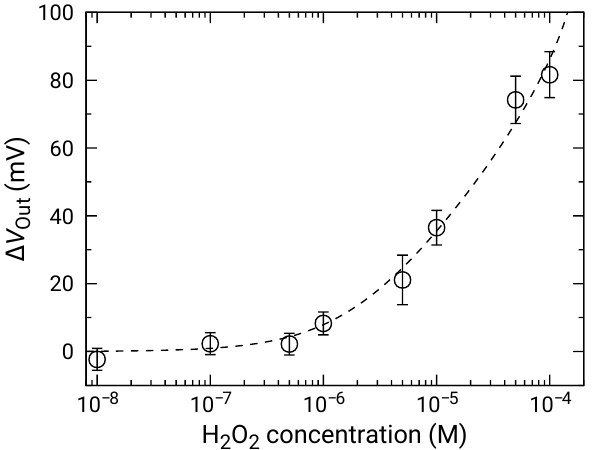
Figure 9. Concentration dependence of sensor output change for addition of H 2 O 2 . Data are plotted after subtracting ∆ V Out for 0 M H 2 O 2 (control) to compensate for output